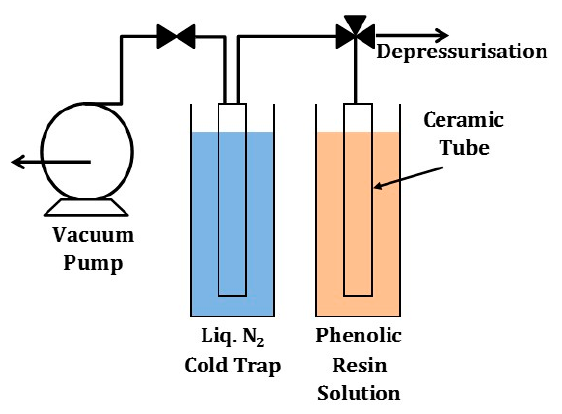
Figure 1. Schematic of the vacuum-assisted impregnation method. Table 2. Substrates used for the preparation of carbon membranes.